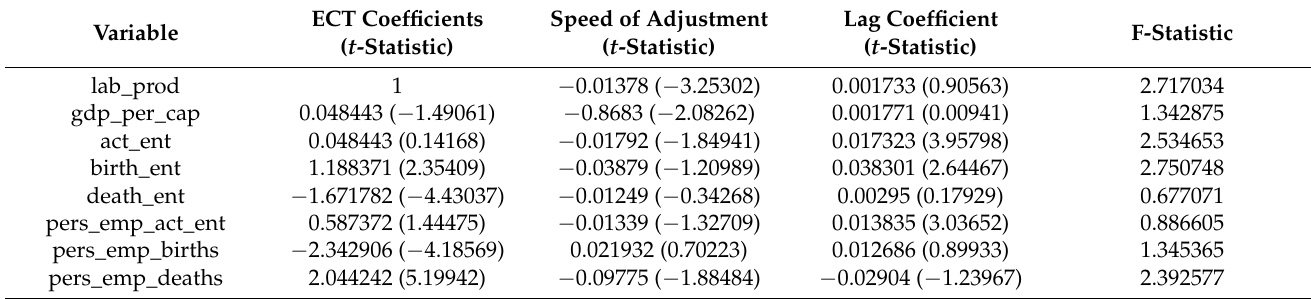
Table 12. Estimation of error correction term in the VEC